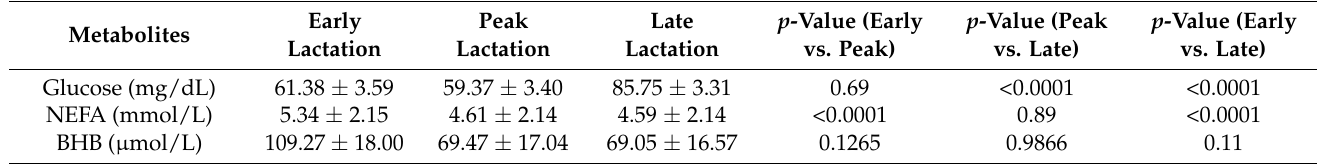
Table 2. Changes in blood metabolites across